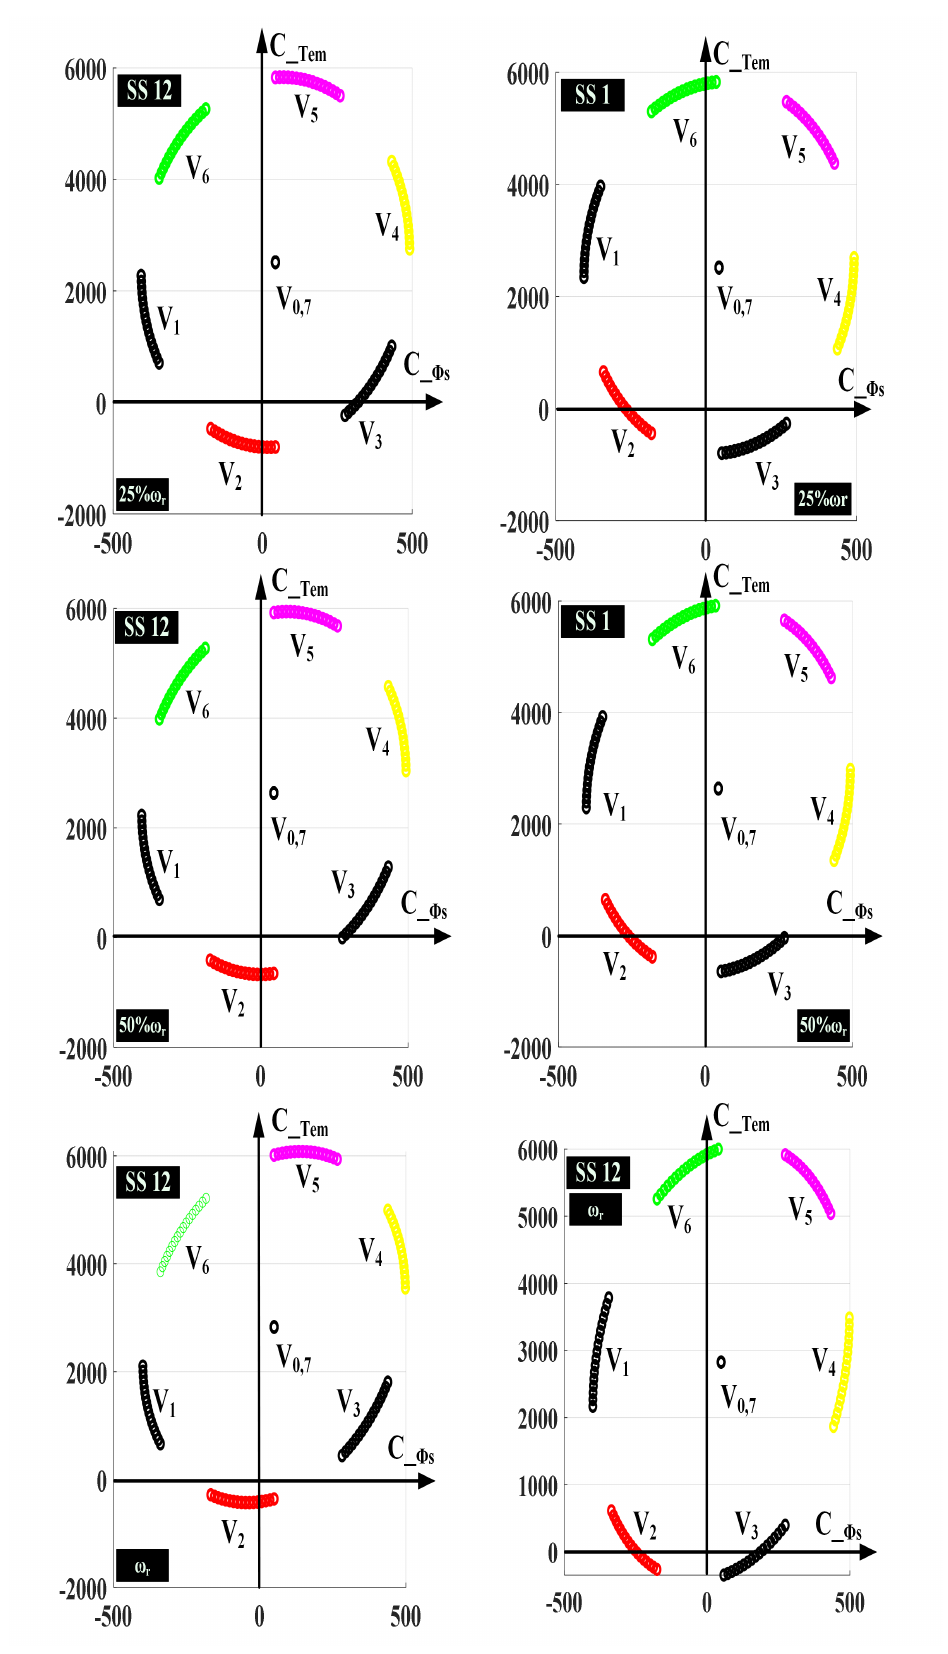
Figure 5. Effect of the voltage vectors on the error variation of both torque and stator flux for different